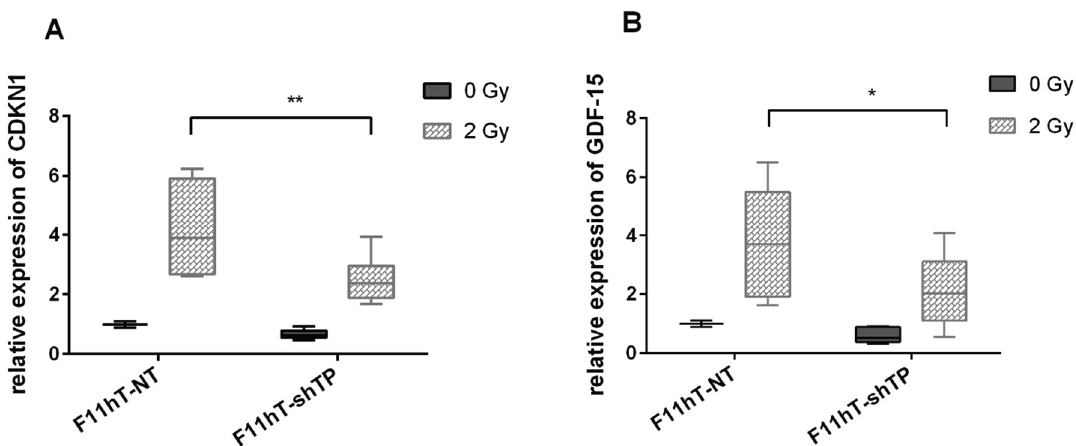
Figure 7. TP53inp1 silencing alters expression of IR–induced p53 targets. Graphs